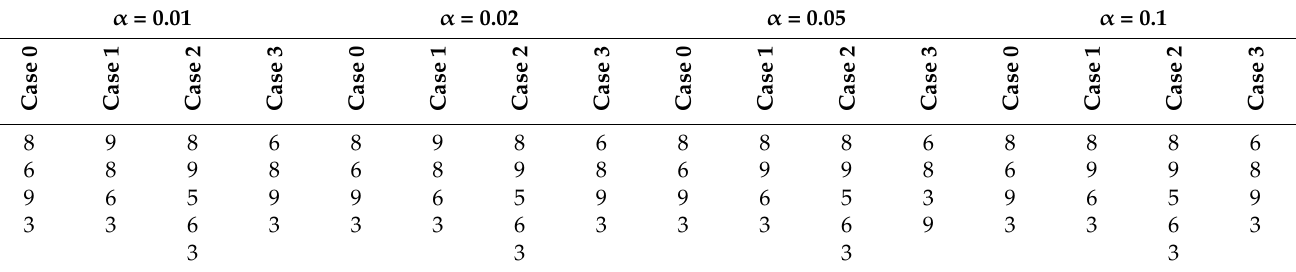
Table 27. Ranking Lists of Candidate Nodes for Location of Additional Reactive-Power Sources.